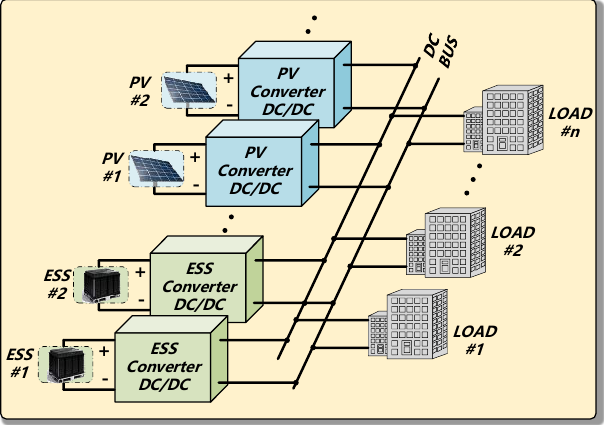
Figure 2. Structure of a DC microgrid in off-grid operation.